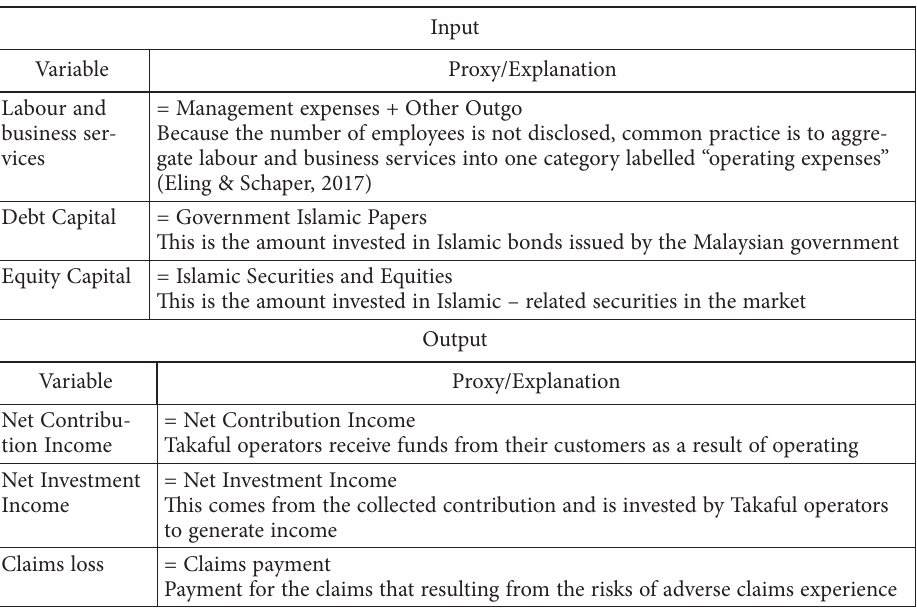
Table 1. Input and output